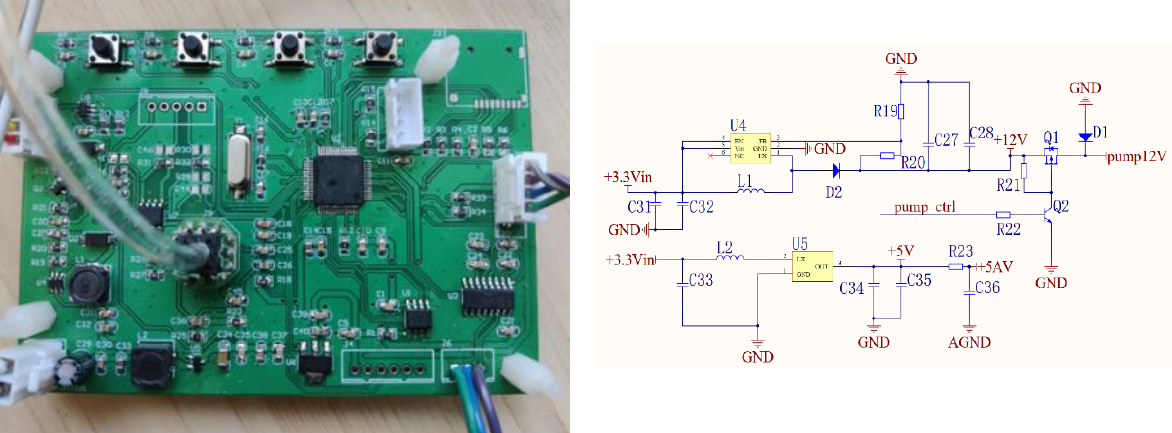
Figure 3. The control circuit board and part of the circuit schematic